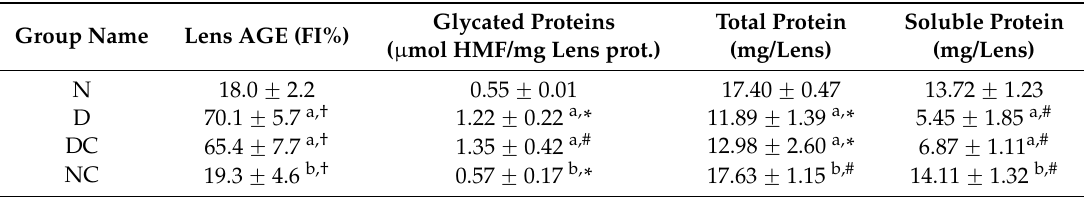
Table 3. The effect of crocin(s) on various markers of protein glycation and protein content of the rats